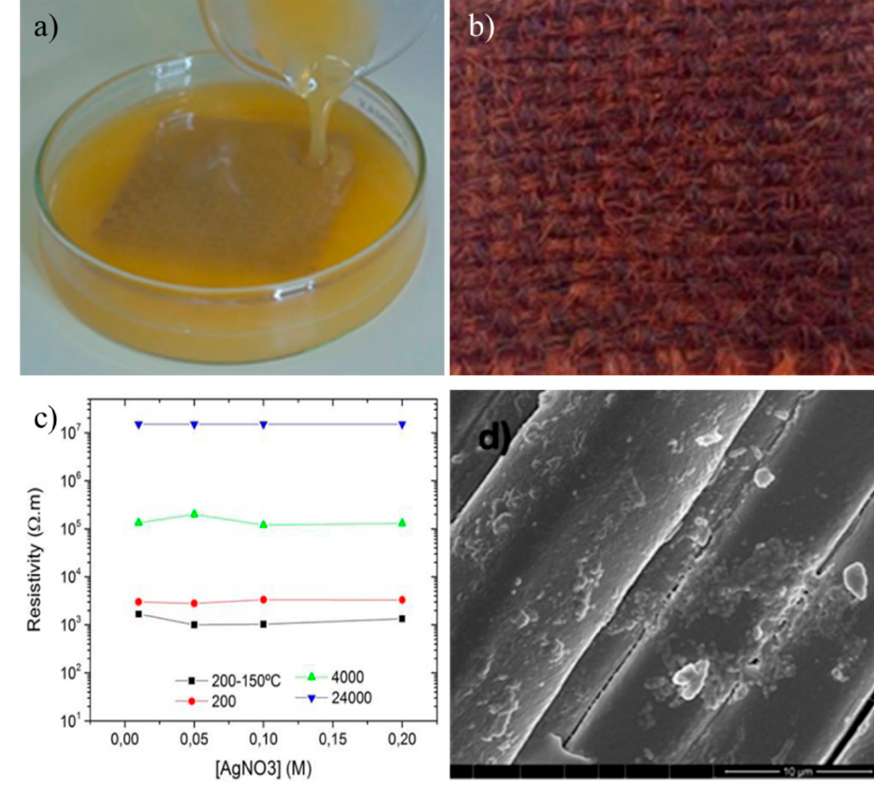
Figure 7. Jute fabric impregnated with Ag 0 -PEG suspension ( a ). Jute fabric with Ag 0 -PEG NPs ( b ). Dependence of the resistivity values on AgNO 3 concentration ( c ) FESEM images of jute fabrics functionalized with Ag NPs ( d ) [85].